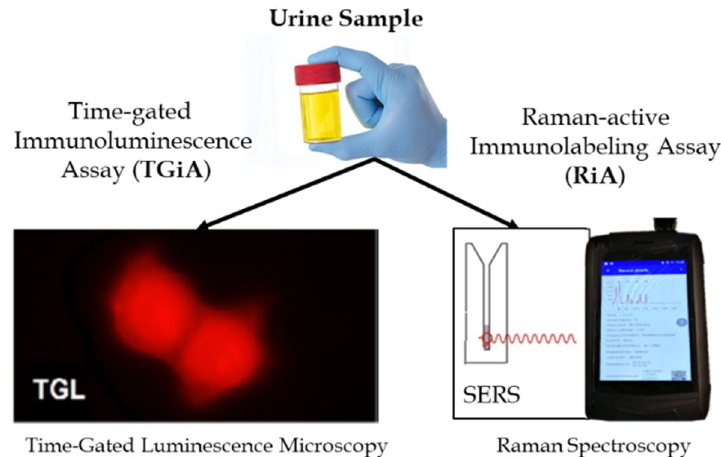
Figure 1. TGiA and RiA assays for immunodetection of PCa cells in (male) patient’s